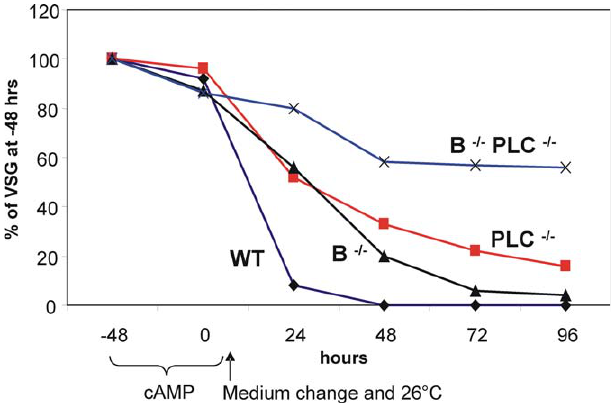
Figure 7. VSG Levels during BSF-to-PRO Differentiation The VSG bands on the western blot shown in Figure 6B were quantitated by densitometry for each of the four cell lines during BSF-to-PRO differentiation. The VSG intensities were normalized to the tubulin levels at each time point and the initial VSG level ( (cid:2) 48 h) for each cell line was set at 100%. The VSG level shown for each time point is a percentage of initial VSG levels. The amounts of VSG remaining in B (cid:2) / (cid:2) (triangles), PLC (cid:2) / (cid:2) (squares), and B (cid:2) / (cid:2) PLC (cid:2) / (cid:2) (x) cells all decline more slowly than that of WT (diamonds) cells during differentiation. At 96 h, B (cid:2) / (cid:2) PLC (cid:2) / (cid:2) cells have approximately 60% VSG remaining, compared to 16%, 5%, and 0% in PLC (cid:2) / (cid:2) , B (cid:2) / (cid:2) , and WT cells,